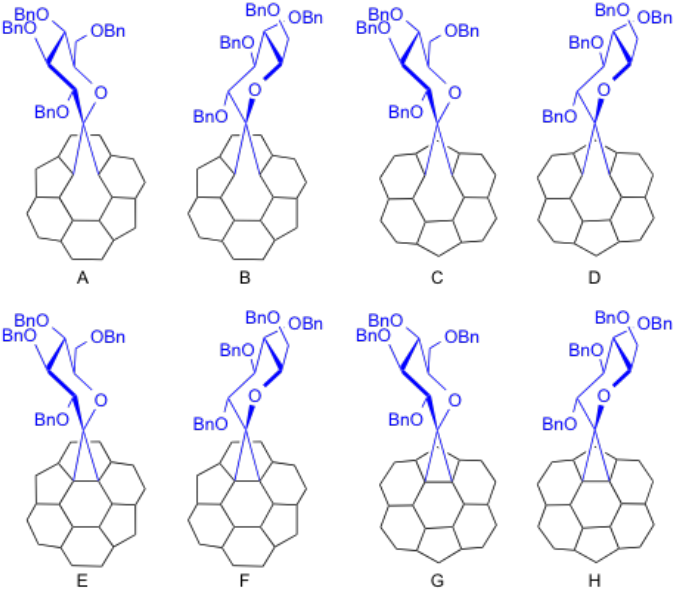
Figure 2. Partial structures of the eight possible isomers